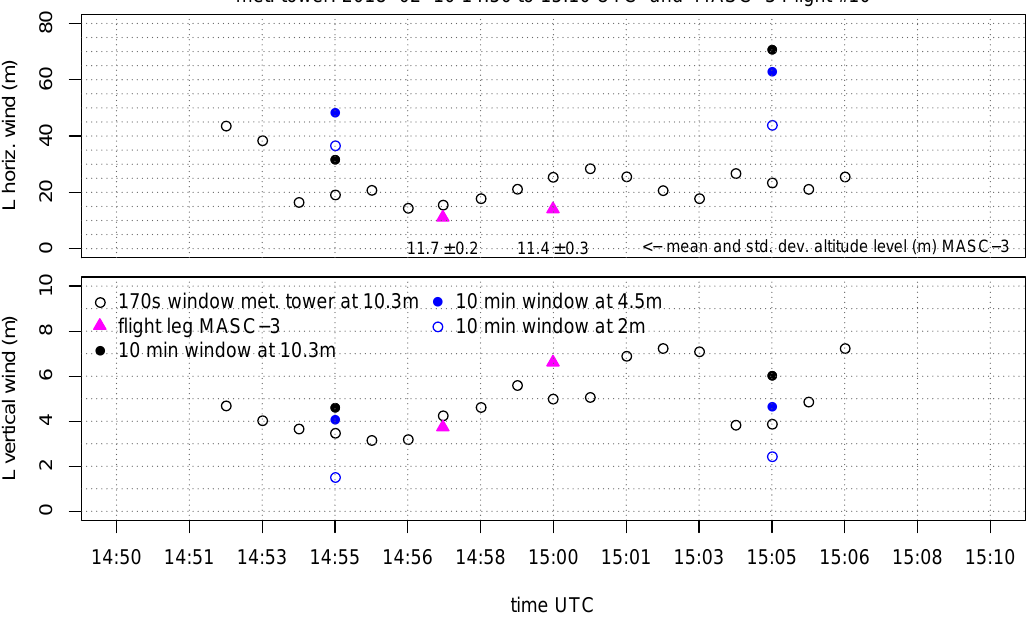
Figure 13. Integral length scales of the horizontal wind L ( v h ) ( top ) and the the vertical wind component L ( w ) ( bottom ). For the tower at 10.3 m, several fractions of the time series with a duration of ∆ t tower = 170 s, corresponding to the fetch of the MASC-3 flight legs with an average duration of ∆ t = 80 s, were used to plot the length scales alongside the values for the individual MASC-3 flight UAS legs. The mean altitude and standard deviation of the individual flight legs are indicated. Furthermore, the integral length scales of the 10 min time series of the tower at all height levels are